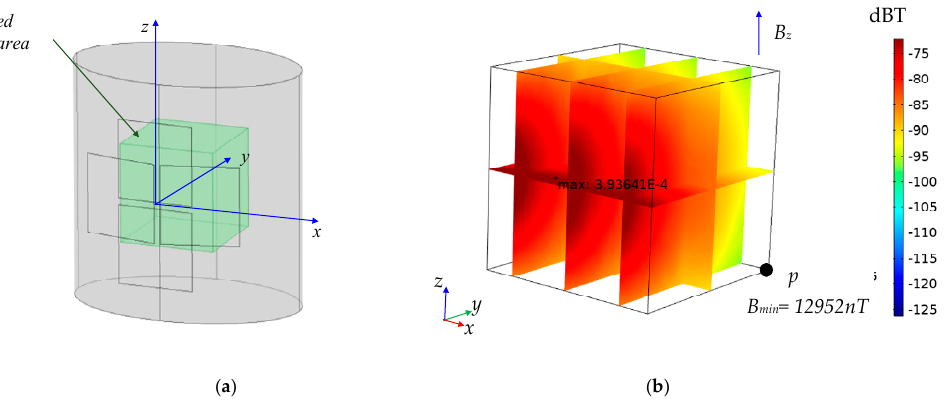
Figure 10. Selected cubic region inside the torso ( a ); distribution of B z inside the cubic region for the worst case scenario ( b ). The minimum value is obtained for the z component of magnetic flux induction, Bz, min = 12.952 μ T, at point p shown in Figure 10b. The excitation algorithm is based on the idea of maximizing magnetic coupling between the transmitting coil and the receiving coil for